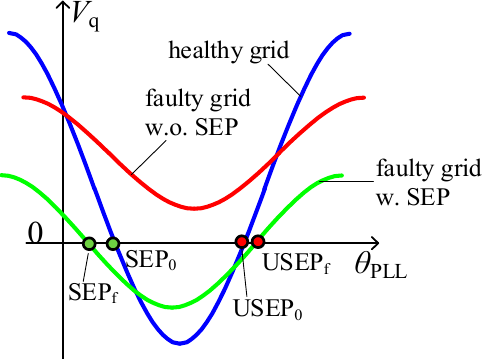
Figure 4. PLL’s trajectories under di ff erent grid situations.